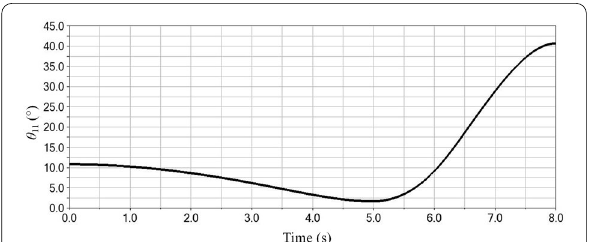
Figure 27 The simulation value of θ 11 when the mechanism avoids singular position 3